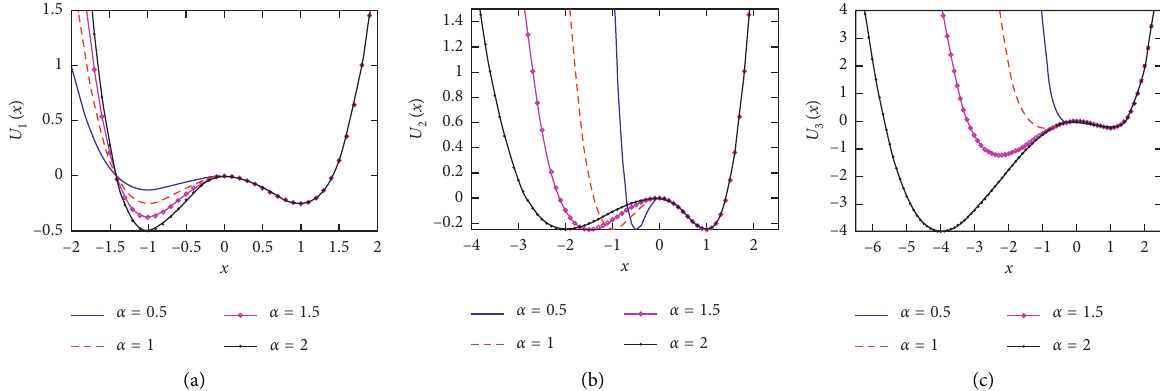
( x ) for different values of α . (b) Potential U 1